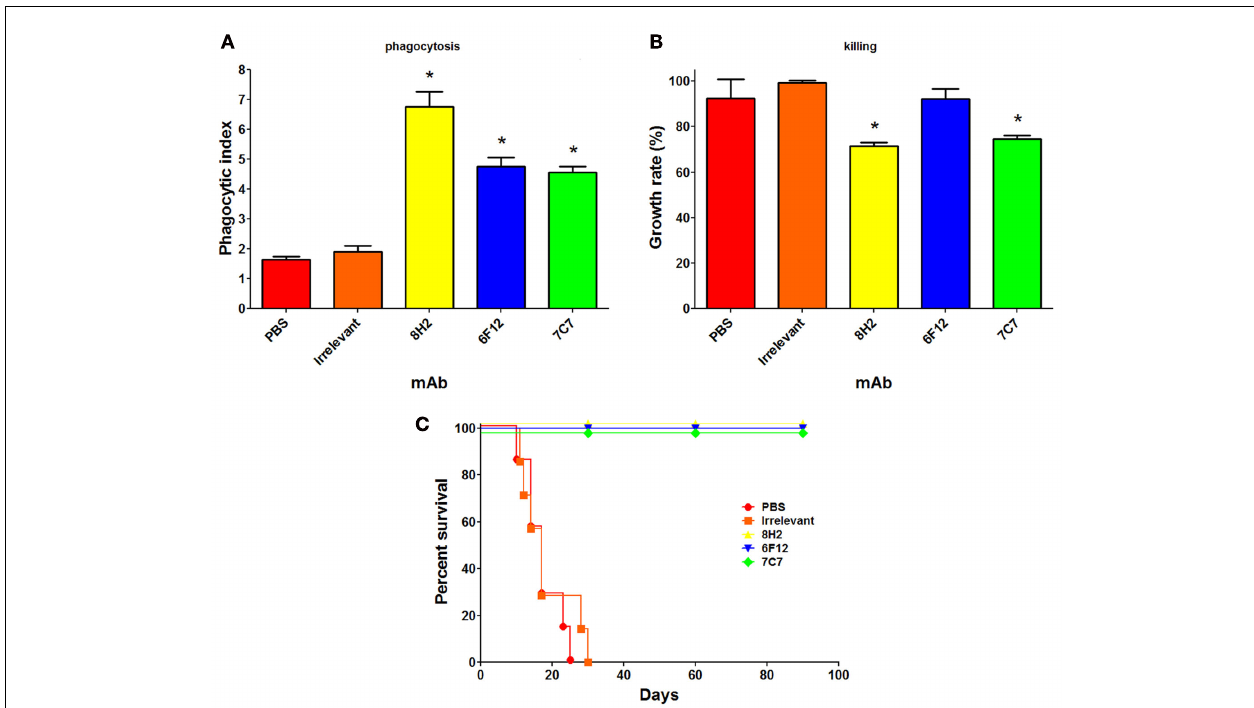
significantly enhanced the uptake of yeast cells by the phagocytes ( p < 0.05 vs. controls) and that two of the three mAbs enabled the killing of yeast cells by the J774.16 cells ( p < 0.05 for mAbs 8H2 and 7C7 vs. controls). (C) C57Bl/6 mice infected with 1.25 × 10 7 opsonized yeast cells had a 100% survival whereas control infected mice died within 1month after infection ( p < 0.001 for mAbs 8H2, 6F12, and 7C7 vs.